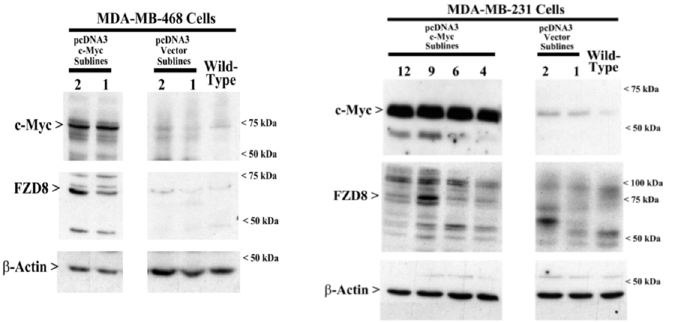
Fig 1. Overexpression of c-Myc increasesFZD8 expression in TNBC cells. Western blot analysis showedstable expressionof c-Myc in MDA-MB-468, MDA-MB-231 and CRL2335cells increasesFZD8 comparedto vector transfected control cells.